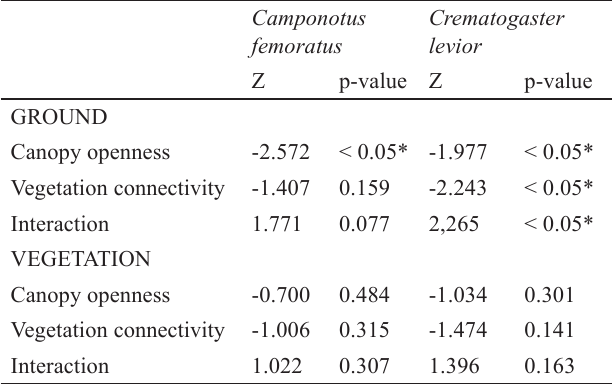
Table 2 . Factors that influence the frequency of use of each stratum by Camponotus femoratus and Crematogaster levior